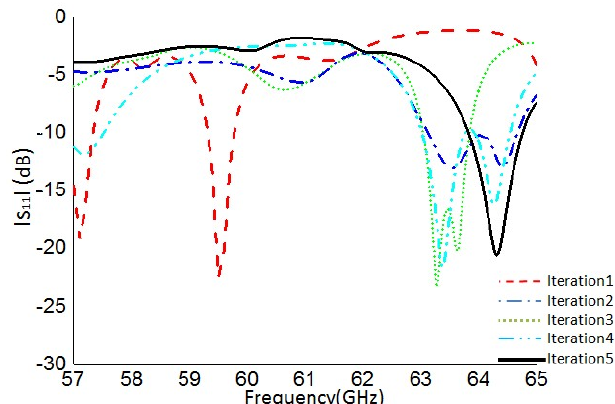
Figure 2. Simulated return loss characteristics of the different iteration of antenna structures with the full ground structure in the bottom plane of the proposed antenna. full ground structure in the bottom plane of the proposed